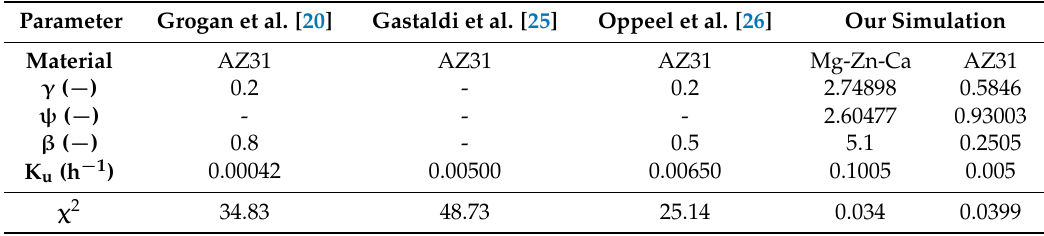
Table 5. The calibrated parameters by different groups in the literature. Gamma ( γ ), Psi ( ψ ), Beta ( β ), and kinetic parameter (K u )